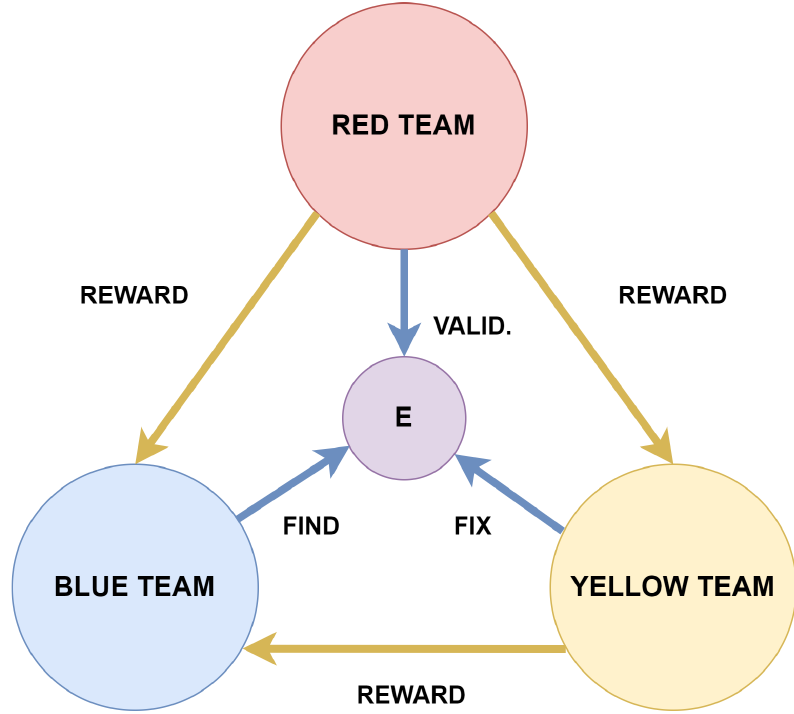
Figure 10. Serious game model.